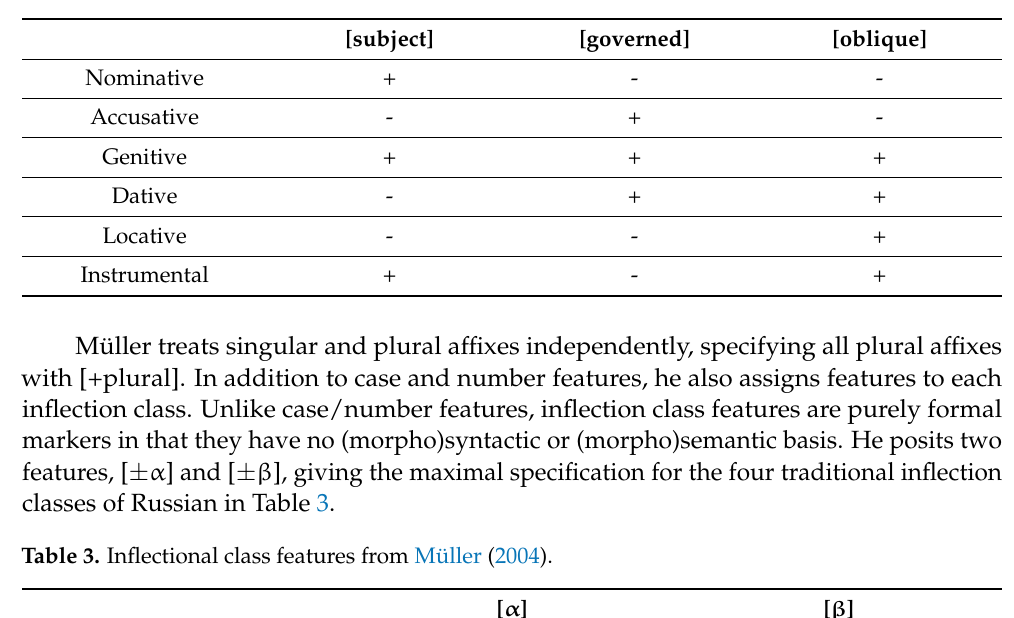
Table 2. Case features from Müller (2004).